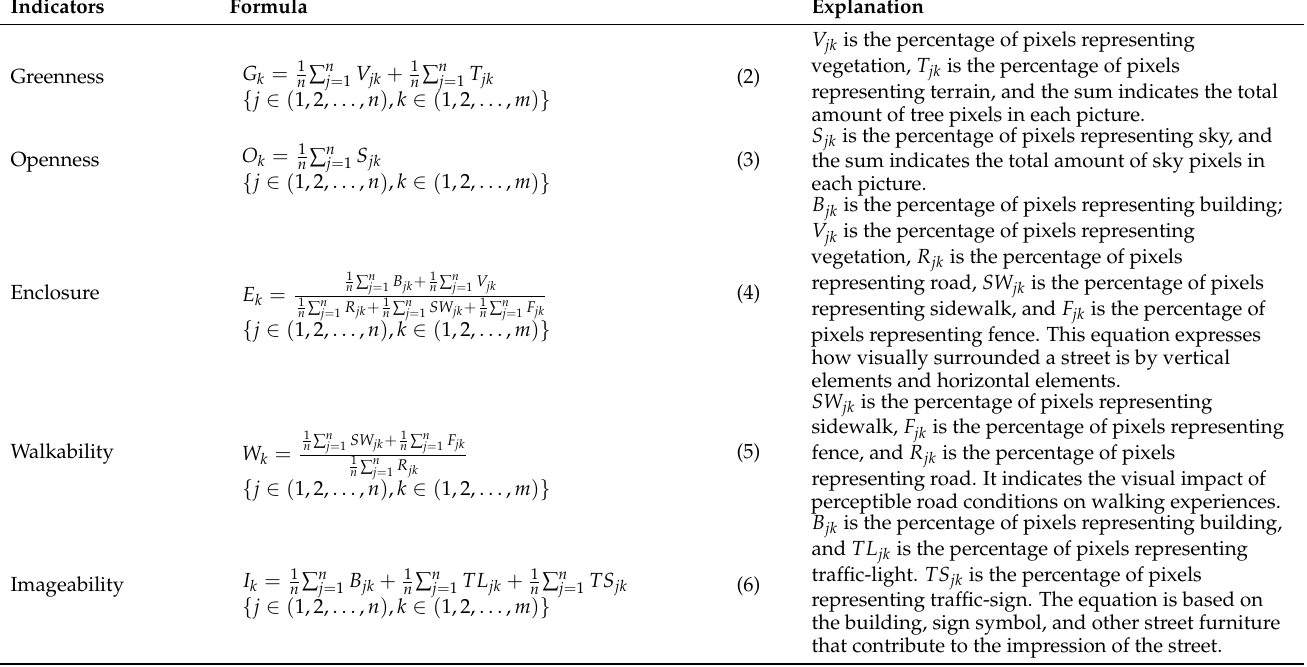
Table 1. Formulate explanations for the five indices of the perception